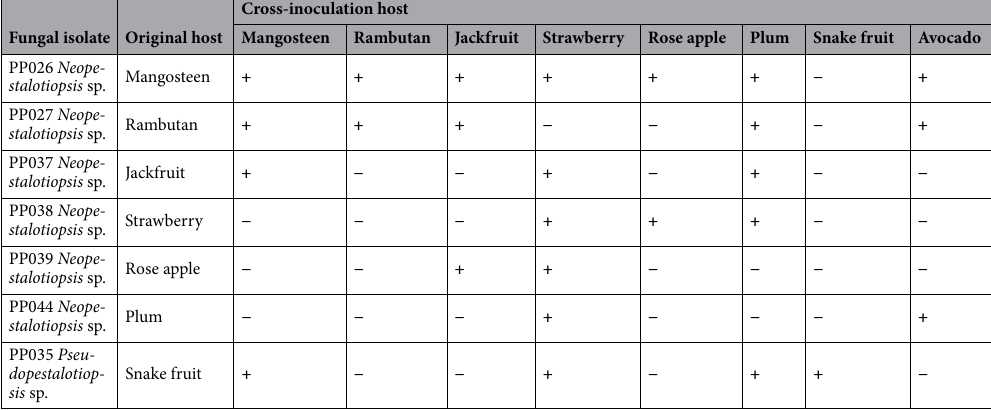
Fungal isolate Original host